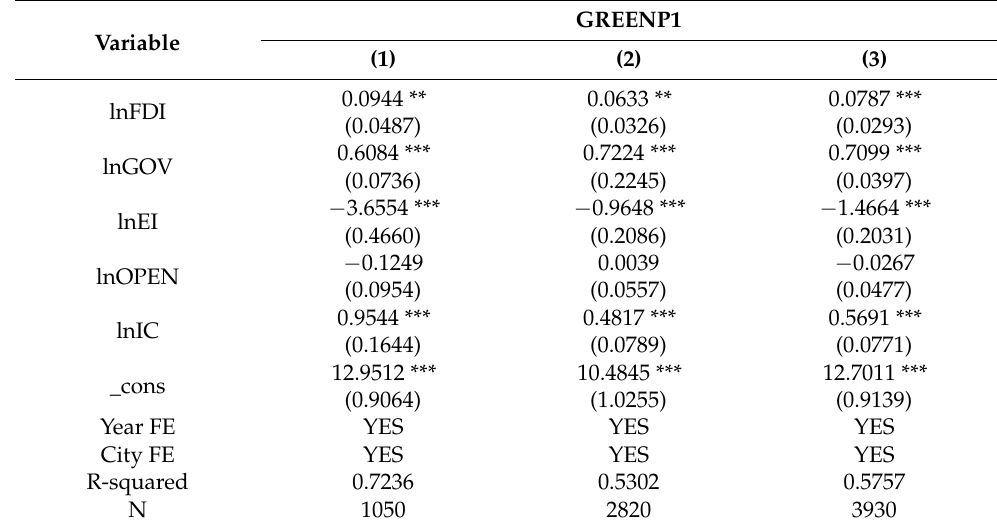
Table 8. Baseline regression results for innovative cities and non-innovative cities.